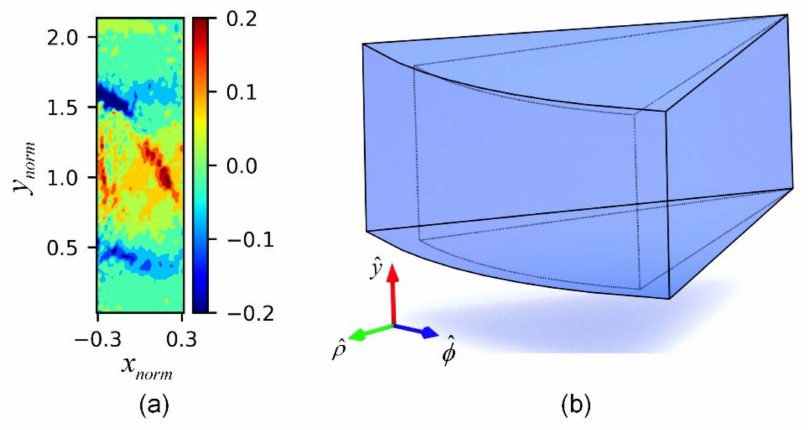
Figure 5. ( a ) Divergence field based on test 092903b at loading level of ε a = 9.6%; ( b ) illustration of deformation associated with positive divergence field.